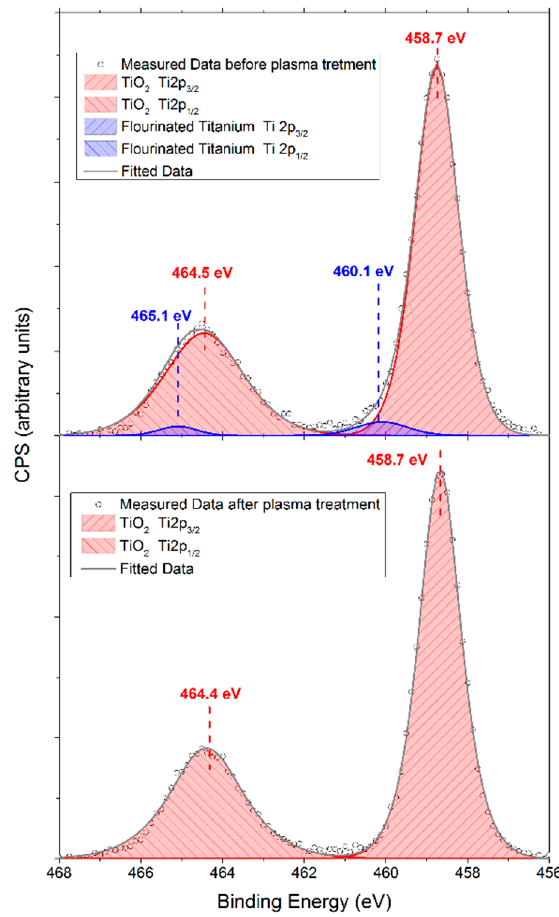
Figure 8. XPS spectra of Ti2p of cTi before and after oxygen plasma treatment.